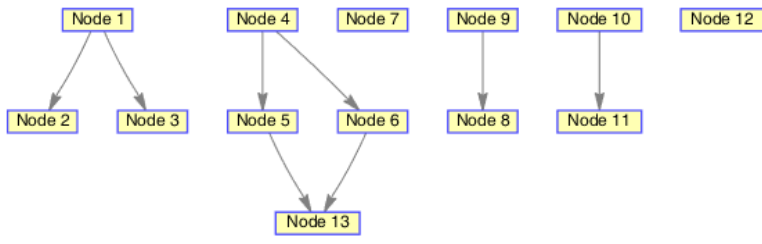
Figure 14. The structure estimation of group targets at k = 70.